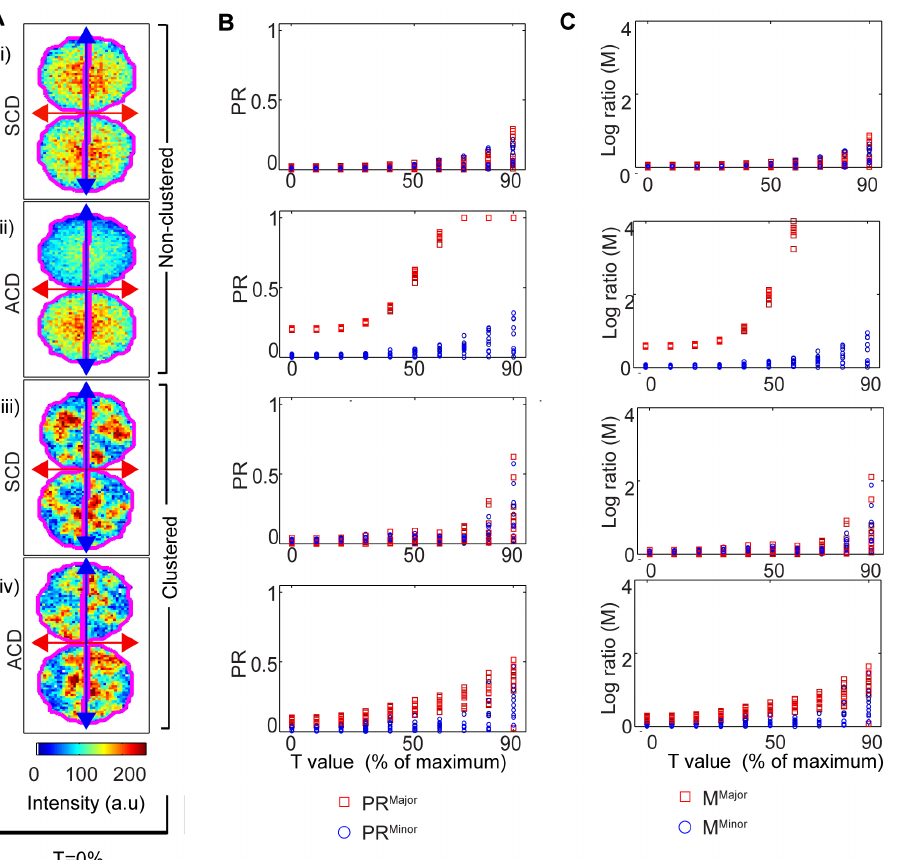
Figure 4. PR major and PR minor are differentially affected by thresholding and clustering. Cells were simulated to be: i) symmetric non- clustered; ii) asymmetric non-clustered; iii) symmetric clustered; iv) asymmetric clustered. ( A ) Examples of simulated cells and approach to hemisphere separation. Blue and red lines describe the major and minor axes respectively, and the magenta contour shows the separation that gave an equal number of pixels to each hemisphere (slightly shifted from the major axis). ( B ) PR major and PR minor values for 10 simulated cells were plotted against T value ( C ) M major and M minor values for 10 simulated cells were plotted against T value. Note that in the asymmetric cells, some fluorescence values were reduced to 0 for the higher threshold settings, causing misleading values of 1 in (B) and infinite (unplottable) values in (C). Input for simulations: h =0, R=22 pixels, number of clusters in D1 and D2 was 20 in the symmetric and 20 and 30 in asymmetric